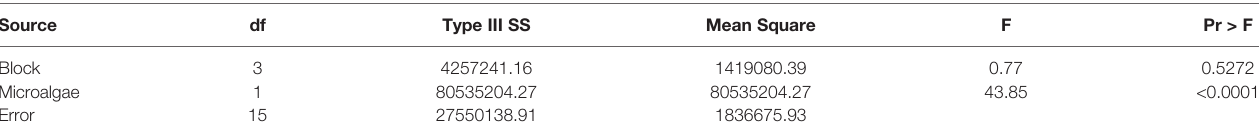
TABLE 1 | GLM (RMANOVA) table summarizing analysis of FR of the pleated tunicate Styela plicata by microalgae treatments of the brown tide-forming pelagophyte Aureoumbra lagunensis , and control species Tisochrysis lutea (Experiment 1). Source